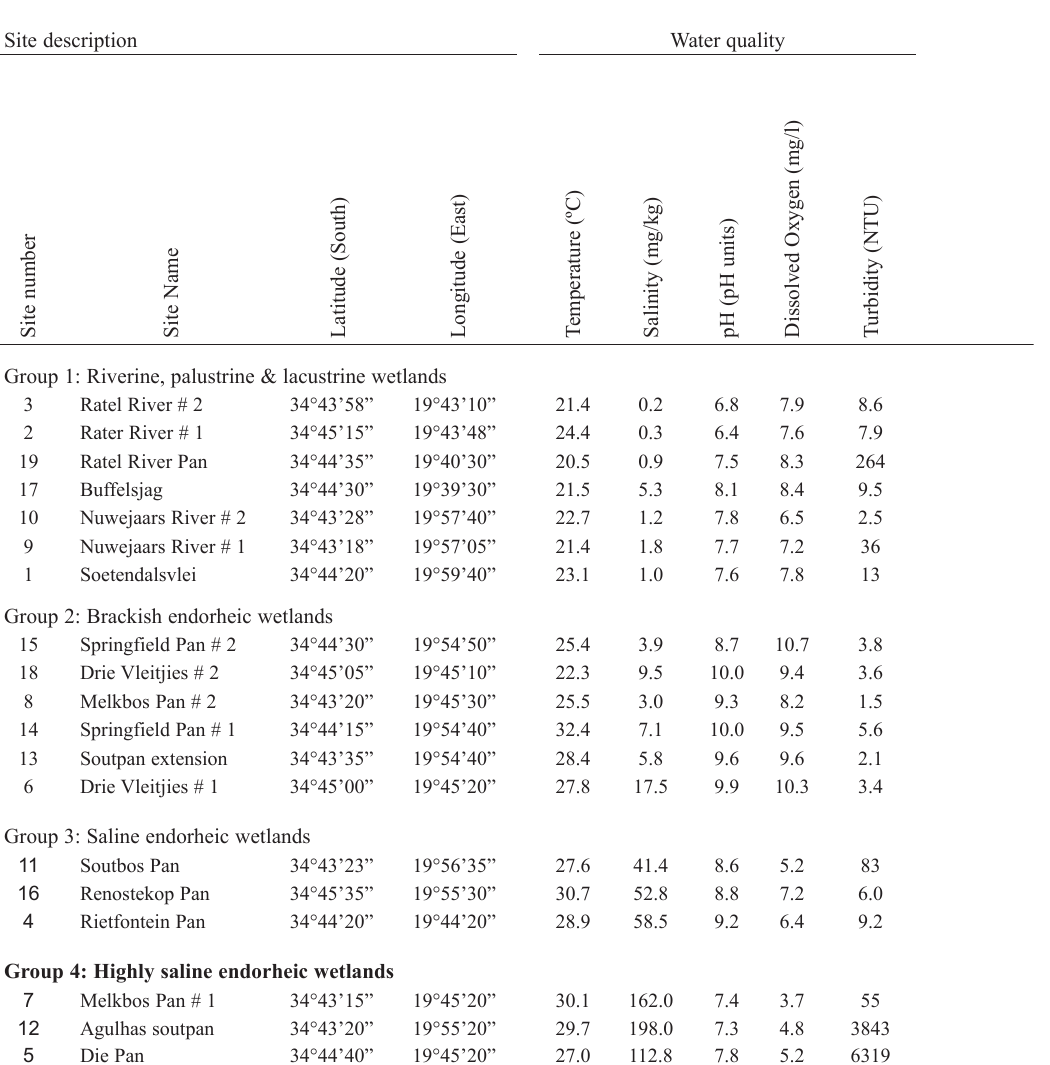
Table 1 Number of fish specimens per species collected in the Agulhas National Park during December 2003